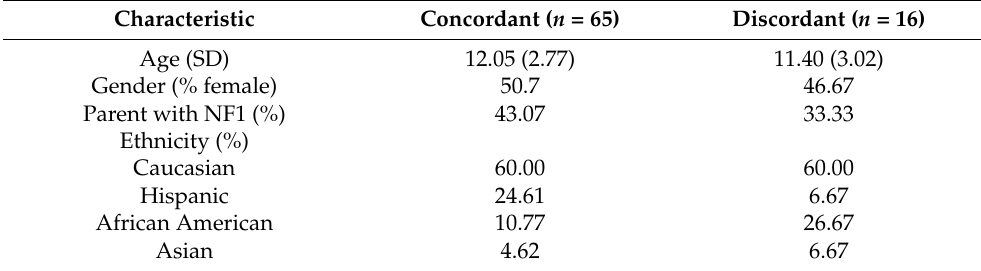
Table 6. Demographic characteristics of concordant and discordant reporting pairs.